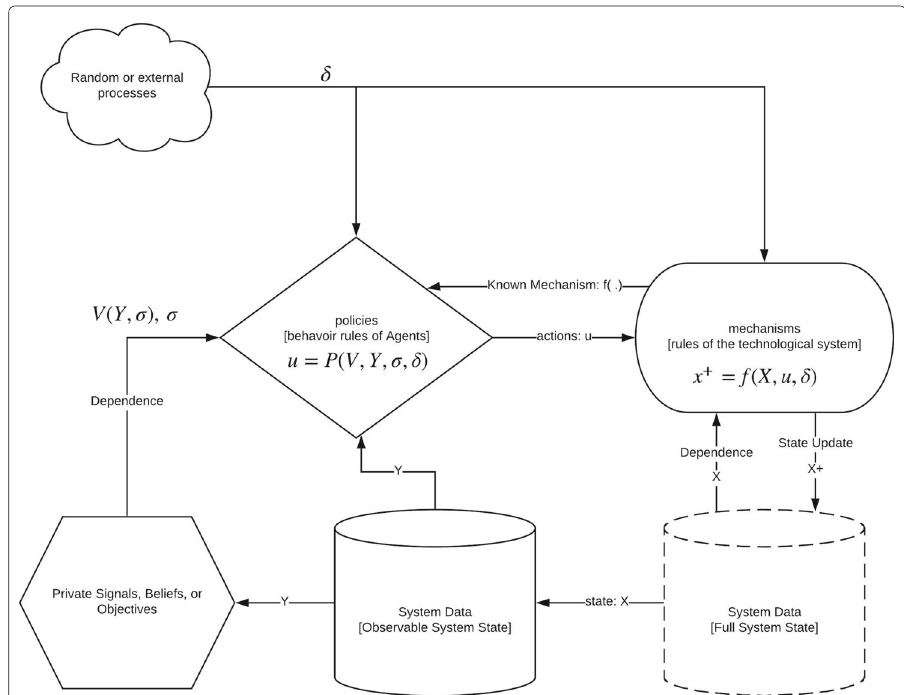
Fig. 1 Expanded representation of the differential game accounting for a variety of factors beyond the states and actions, including private signals σ , private goals V ( · ) , a partially observable state X with an observable subspace Y ⊆ X , and some additional environmental stochastic processes δ drawn from potentially unknown